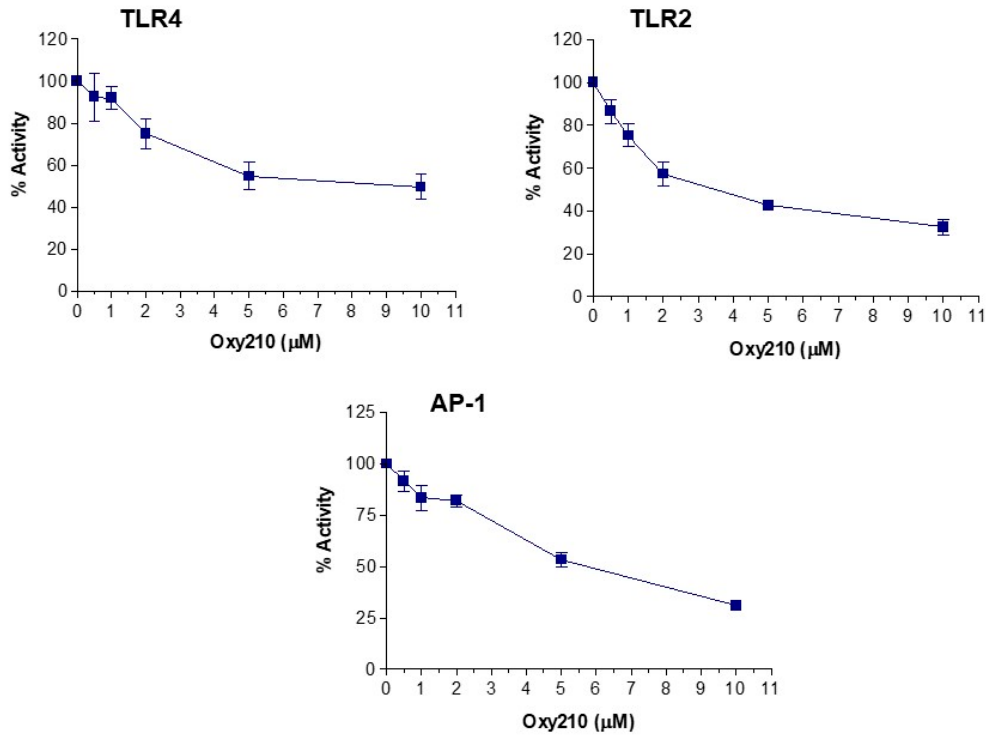
Figure 11. Inhibition of TLR4, TLR2, and AP-1 driven luciferase reporter activity by Oxy210. TLR4 Leeporter TM Luciferase Reporter-HeLa cells, TLR2 Leeporter TM Luciferase Reporter-HEK293 cells, and AP-1 Leeporter TM Luciferase Reporter-HEK293 cells were treated with TLR4 agonist, LPS (25 ng/mL), TLR2 agonist, Pam3CSK4 (1 µ g/mL), or AP-1 activator, PMA (100 ng/mL), respectively, for 6 h in the presence or absence of Oxy210 at the concentrations indicated. Luciferase activity was measured and normalized to the Renilla luciferase activity. Data reported as % activity calculated from triplicate wells per Oxy210 dose ± SD as described in Materials and Methods.